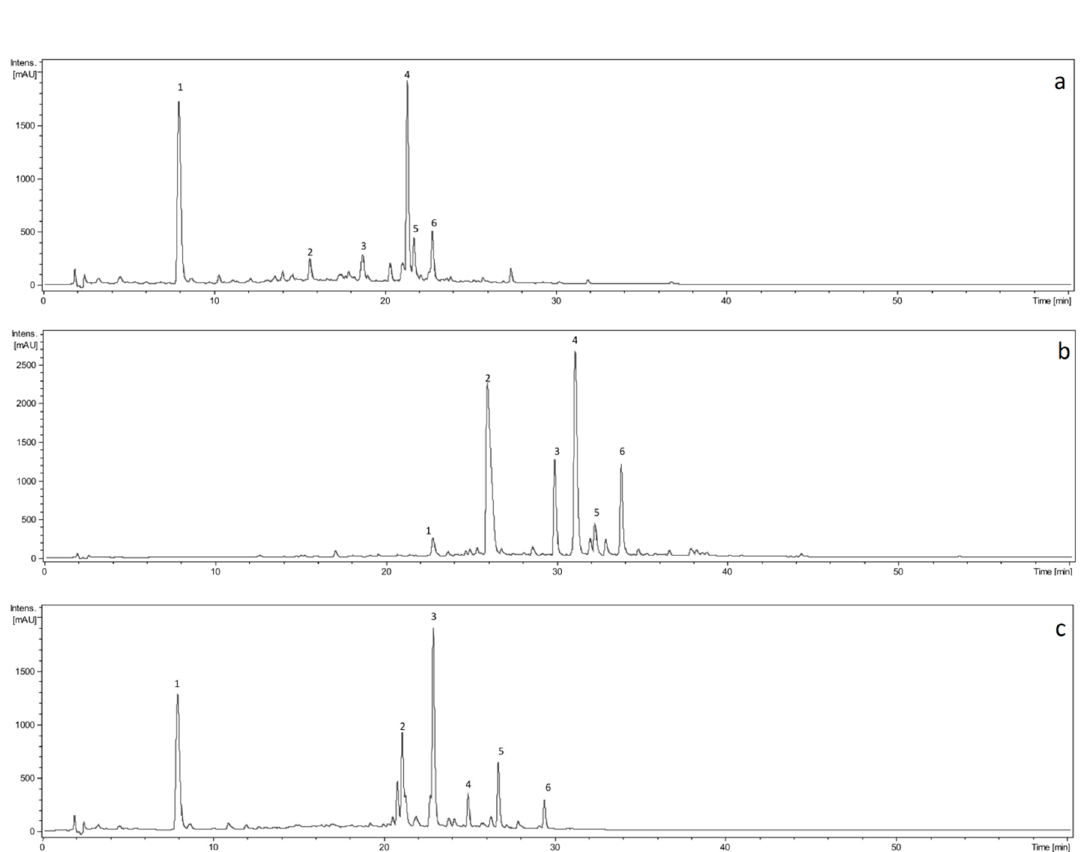
Figure 1. UHPLC-DAD chromatograms of ethanolic-aqueous extracts of ( a ) Millefolii herba ethanolic extract (K EtOH), ( b ) Serpylli herba ethanolic extract (Th EtOH), and ( c ) Arctii lappae folium ethanolic extract (All EtOH), detected at 325 nm. Table 4. The MS2 data of compounds detected in Millefolii herba ethanolic extract (K EtOH), Serpylli herba ethanolic extract (Th EtOH), and Arctii lappae folium ethanolic extract (All EtOH). NL—neutral loss detected corresponding to the cleavage of sugar or phenolic acid.